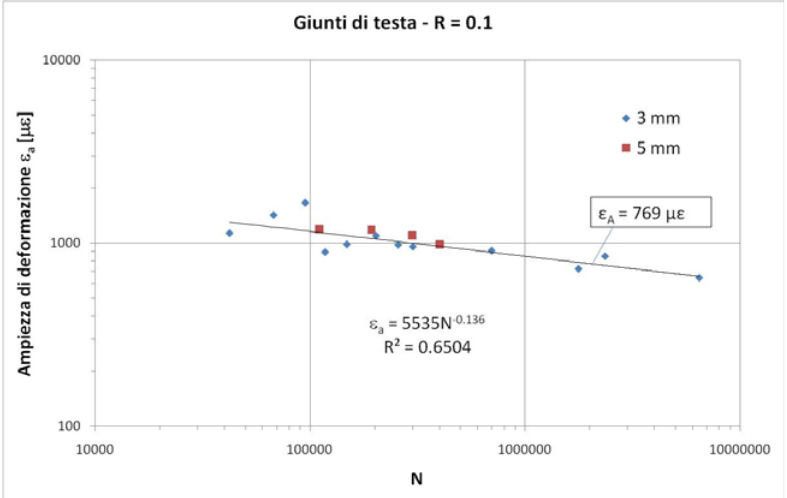
Figura 7: Curve di resistenza a fatica in termini di ampiezza di deformazione locale di giunti saldati in